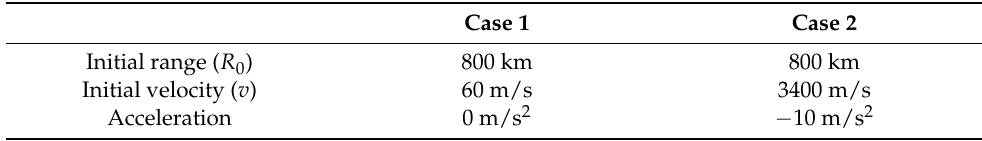
Table 2. Targets motion parameters in different